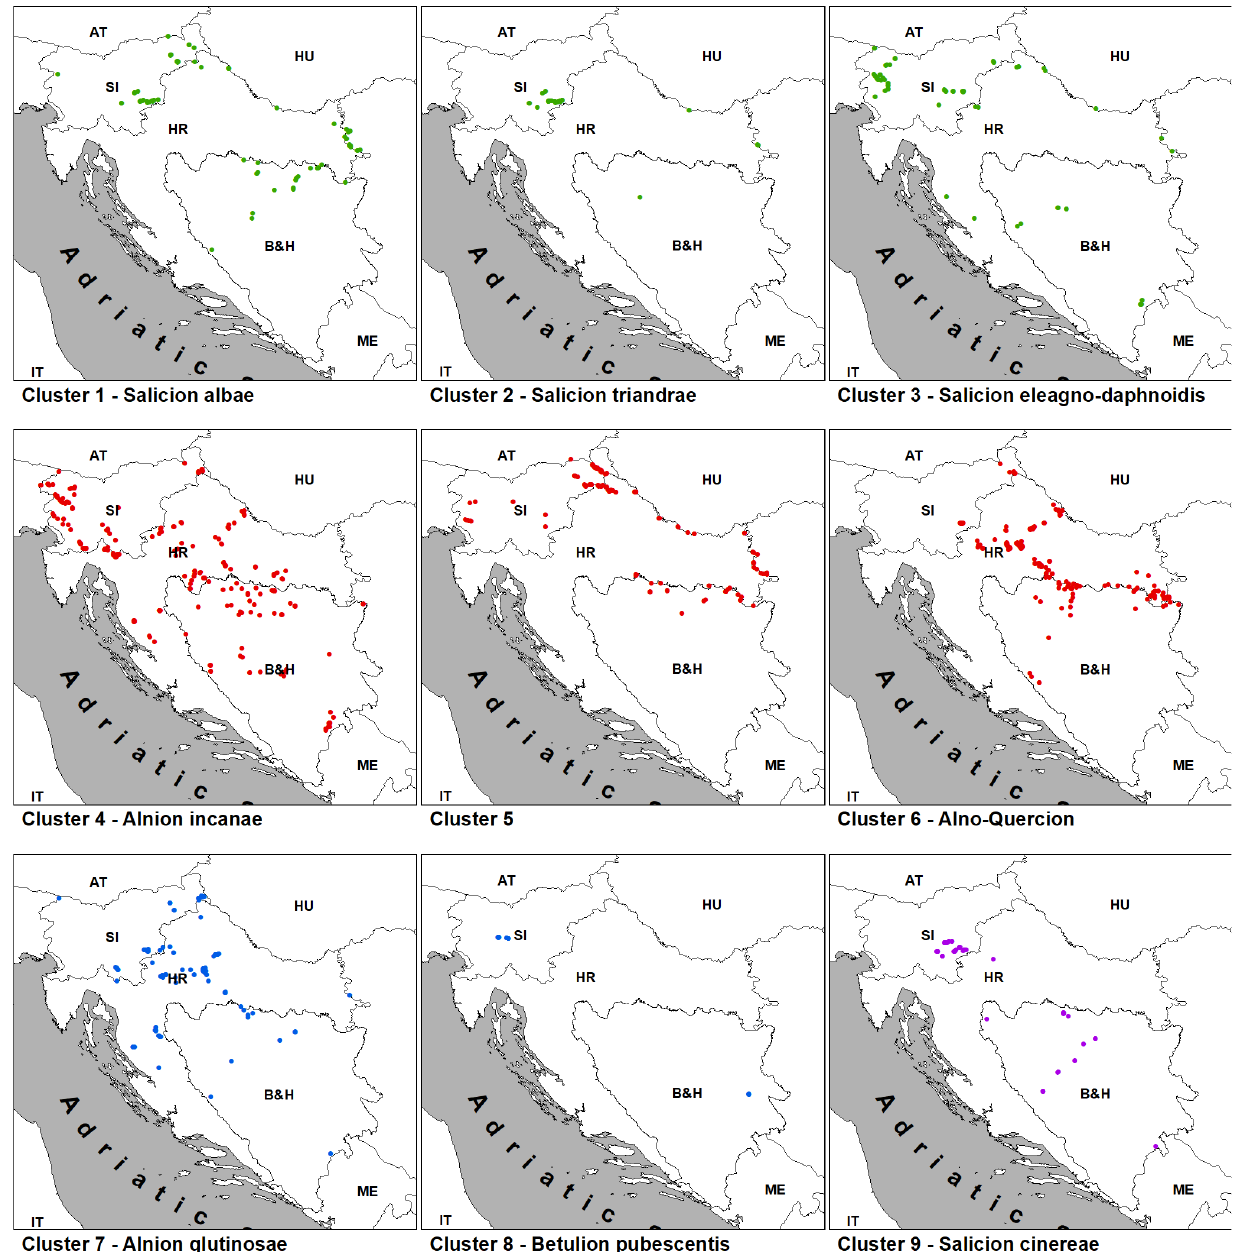
Figure 3. Distribution of relevés classified into the particular cluster. Cluster numbers correspond to Table 1, Figures 2 and 4, Tables S1–S4, Appendix C and to those used in the text. The colors represent groups of clusters (classes): Salicetea purpureae (green), Alno-Populetea (red), Alnetea (blue) and Franguletea (purple).